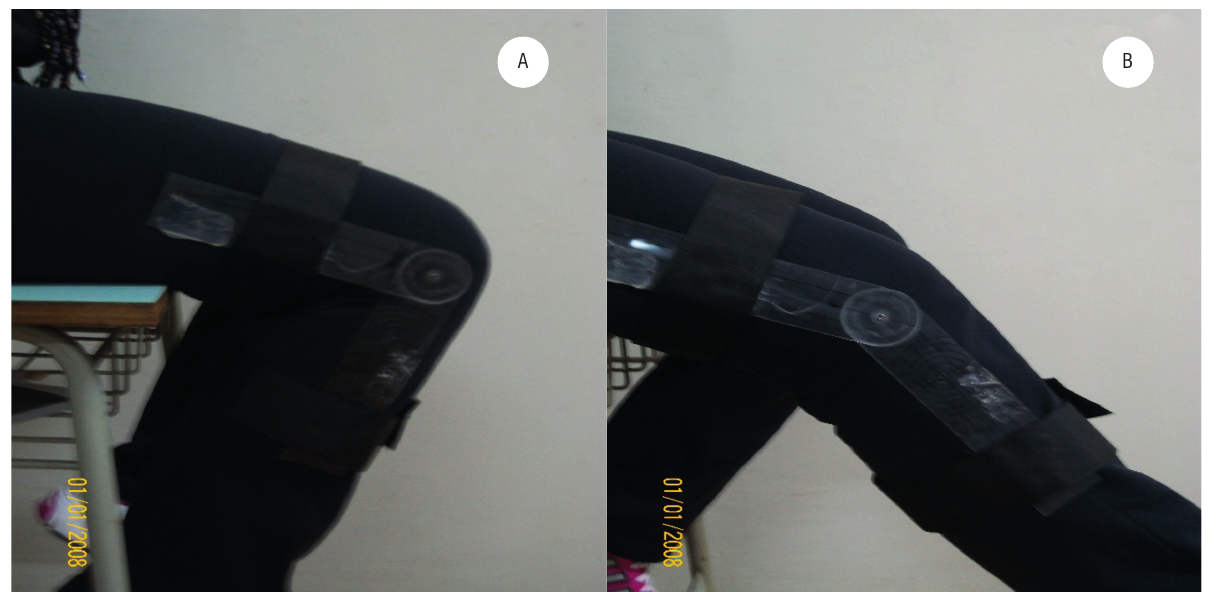
Figura 1 - Ilustração da realização do teste proprioceptivo de joelho. A partir da posição inicial 90 ˚ de flexão do joelho, o avaliador movia passivamente o membro inferior até um angulo de 40 ˚ de flexão de joelho ou de 130 ˚ de extensão de joelho (Figura 1-A e 1-B, respectivamente). Depois, o sujeito era estimulado a posicionar voluntariamente o joelho em 40 ˚ de extensão (Figura